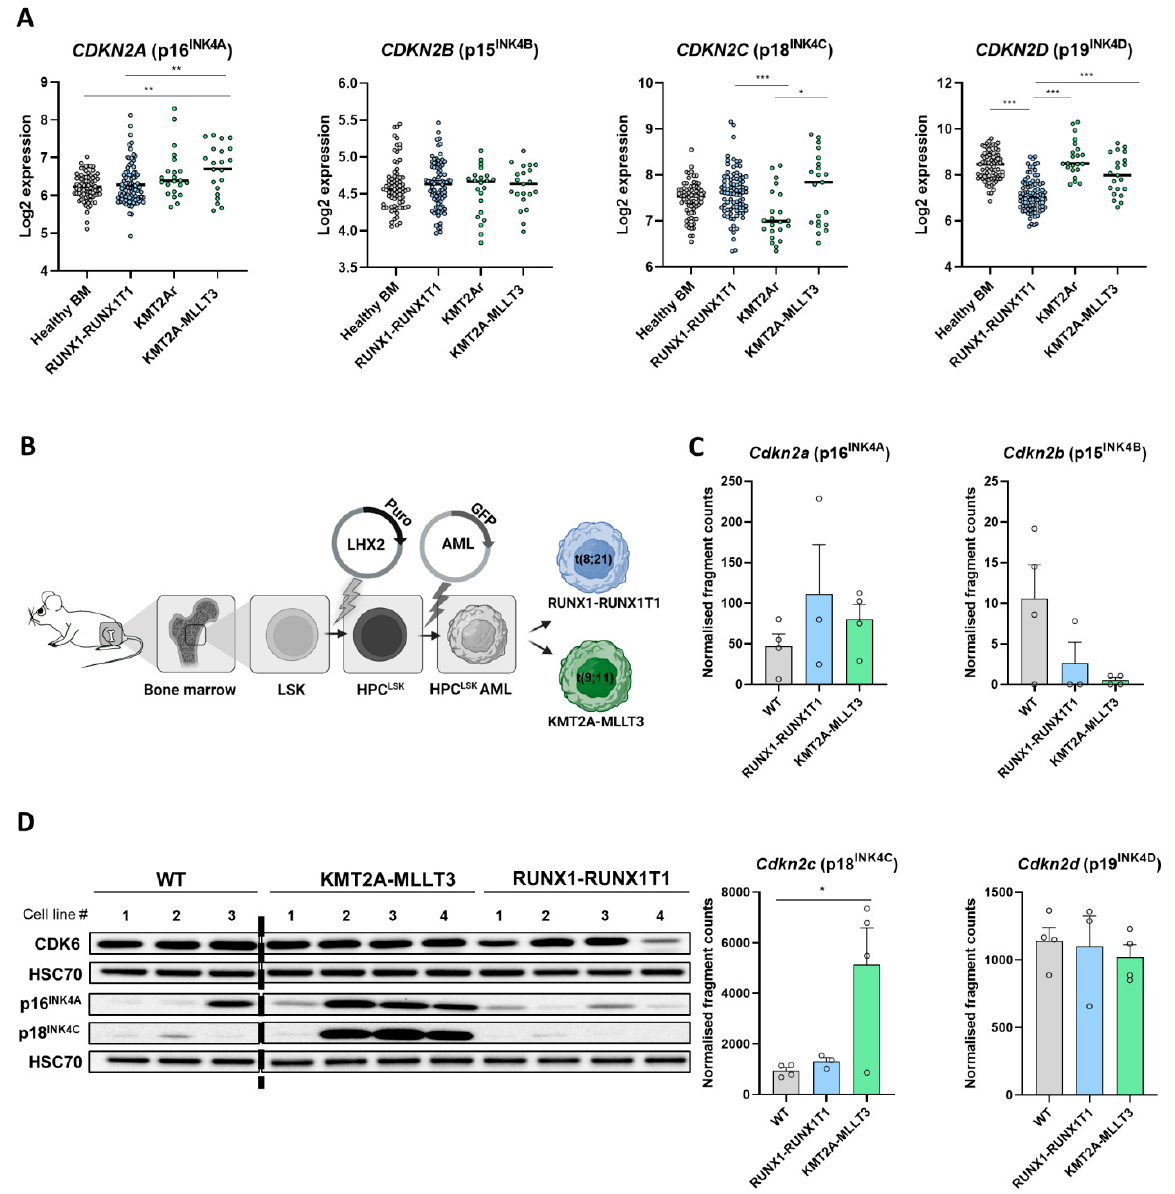
Figure 1. INK4 protein levels differ among AML subtypes. ( A ) The RNA expressions of INK4 genes from human AML patient microarray datasets were analysed: healthy bone marrow, BM ( n = 74); RUNX1-RUNX1T1, t(8;21) ( n = 86); KMT2A rearrangements, KMT2Ar (11q23) ( n = 22); KMT2A-MLLT3, t(9;11) ( n = 21). The KMT2Ar contained no KMT2A-MLLT3 samples. The line represents the median; * FDR < 0.05; ** FDR < 0.01; *** FDR < 0.001. ( B ) A schematic representation of experimental procedure. Murine bone marrow cells were isolated and immortalised with an LHX2 plasmid vector for generating HPC LSK lines. HPC LSK cells were then transformed by the integration of human RUNX1-RUNX1T1 t(8;21) (GFP) or KMT2A-MLLT3 t(9;11) (Venus) plasmid vectors. ( C ) The RNA expression of INK4 genes in the HPC LSK WT ( n = 4), RUNX1-RUNX1T1+ ( n = 3) and KMT2A-MLLT3+ ( n = 4) cells taken from a RNA sequencing dataset: * p = 0.0299. ( D ) The immunoblot of the different biological replicates of HPC LSK WT ( n = 3), KMT2A-MLLT3+ ( n = 4) and RUNX1-RUNX1T1+ ( n = 4) cells detecting CDK6, p16 INK4A and p18 INK4C . HSC70 served as a loading control. The uncropped immunoblots are depicted in Figure S5 and the densitometry quantification is presented in Figure